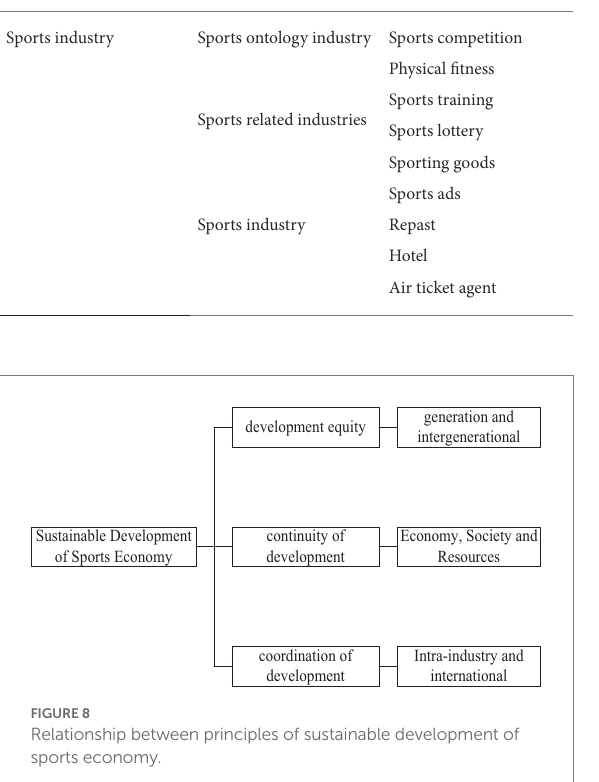
TABLE 1 Sports industry classification.